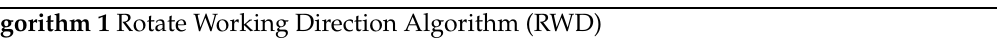
Figure 5. Procedures of the proposed decentralized local coverage optimization algorithm.